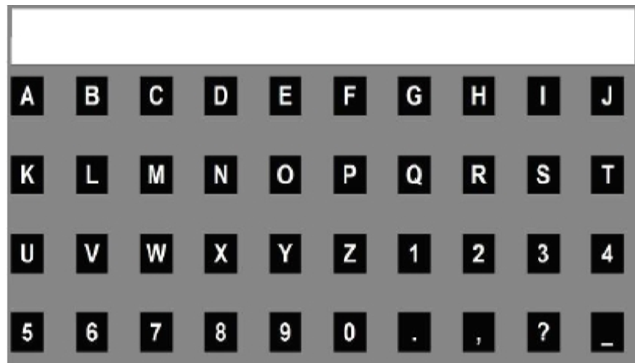
Figure 2. P300-speller interface of Dataset